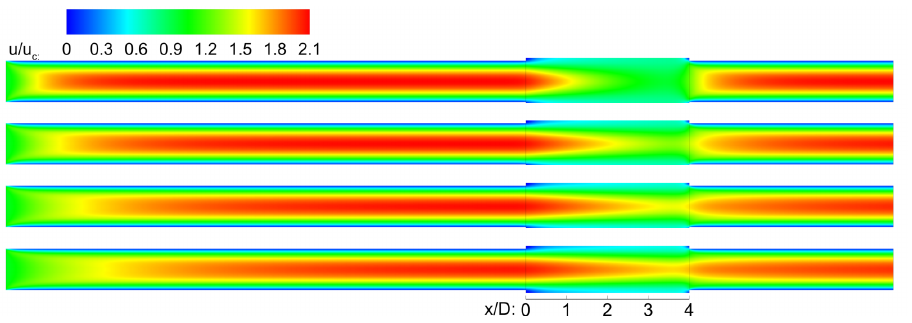
1 Figure 3. Effect of increasing Re at a constant spacing between substrates. Channel Re 50, 100, 150, and 200 from top to bottom. The contours are from planes along of the center of the domain.